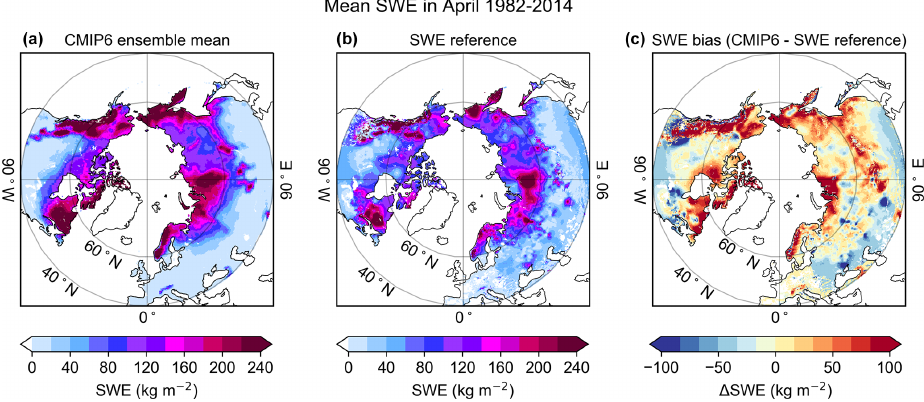
Figure 1. Mean SWE in April for the CMIP6 high-resolution (100km) multi-model ensemble mean (a) , and the SWE reference data (b) and the model SWE bias (c) for the period